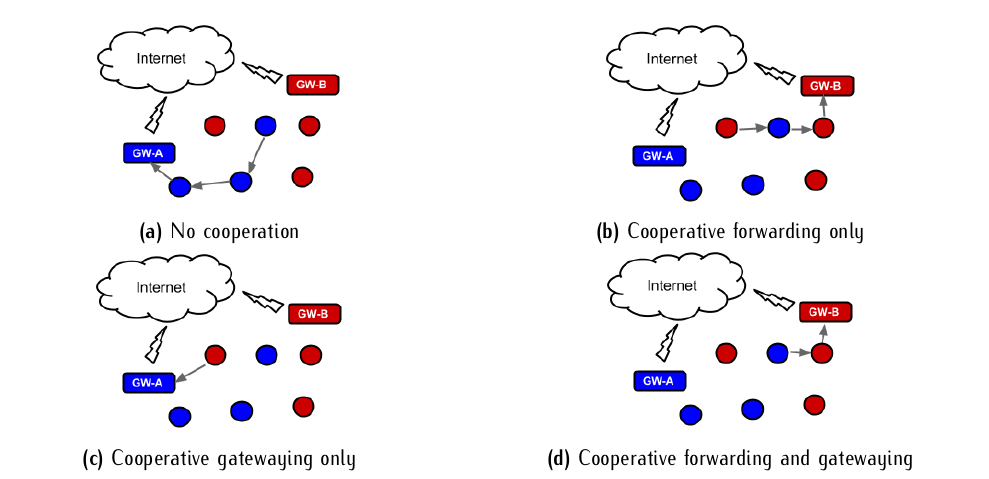
Figure 1. Various IoT service provider cooperative schemes are illustrated in (b)-(d), while the default ’no-cooperation’ scenario is depicted in (a)